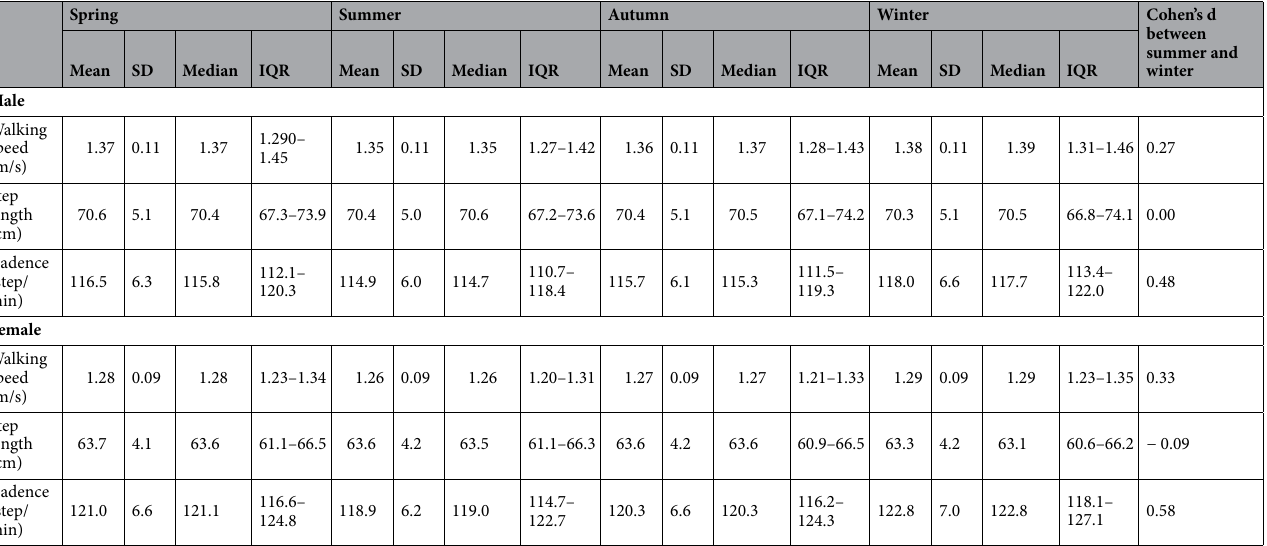
Table 1. Comparison of walking parameters between seasons. IQR interquartile range, Linear mixed model and Bonferroni post-hoc test. Male: Not significant: All seasons in step length, others: P < 0.05. Female: Not